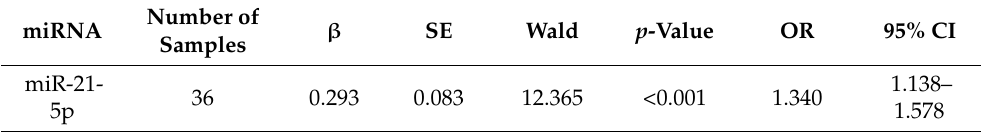
Figure 1. The expression of EVs-miR-21-5p in ESCC plasma. ( A ) Scheme of isolation of tumor-derived EVs from the plasma with anti-EpCAM. ( B ) The expression of tumor-derived EVs-miR-21-5p. ( C ) ROC curve analysis of miR-21-5p. EpCAM, epithelial cell adhesion molecule. Table 1. Aberrant expression of EVs-miR-21-5p was associated with a high risk of esophageal carcinoma as determined by logistic regression analysis.